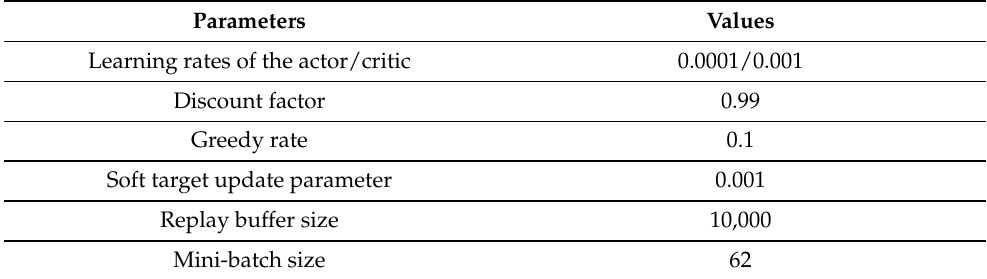
Table 2. Simulation Parameters for RL model.